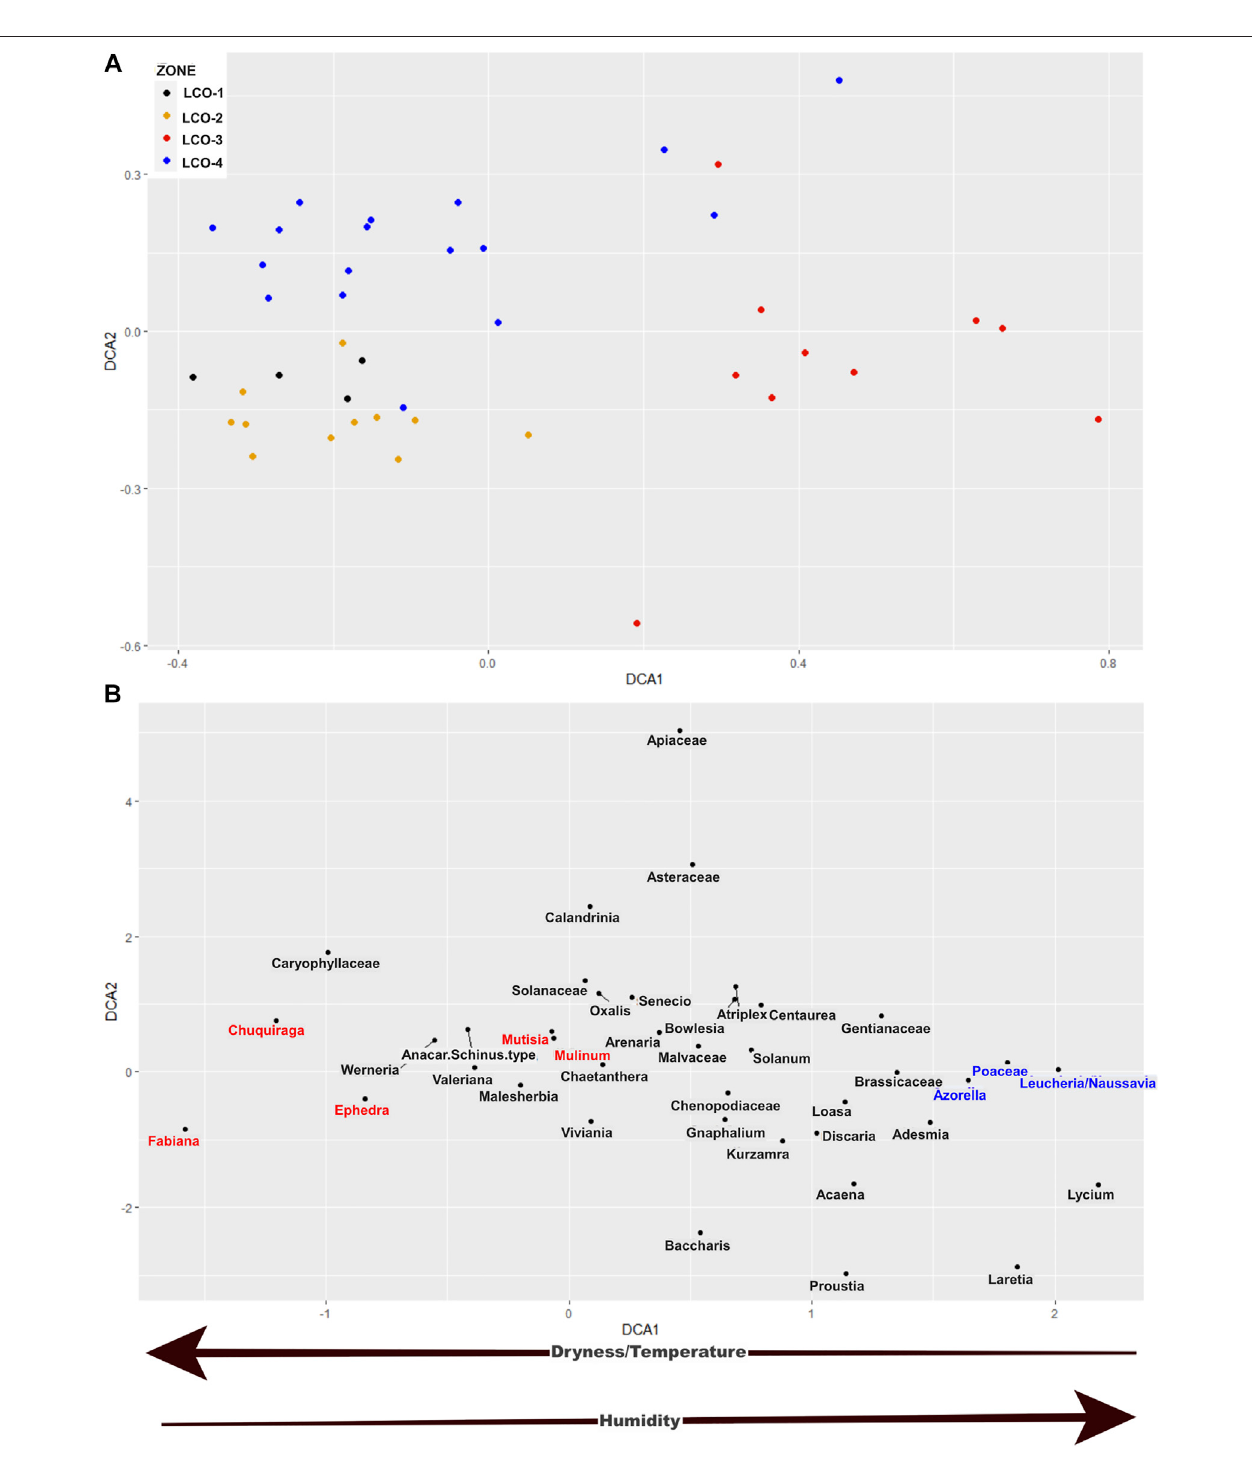
FIGURE 6 | DCA results from the pollen abundance of Laguna Corralito. (A) Ordering of the levels (colored points) grouped in the zones, obtained by the cluster analysis; on the left, are the levels with environmental conditions of lower humidity and on the right, the levels with higher humidity. (B) Ordering of pollen types with a similar arrangement in the multivariate space as the levels. Pollen types related to warmer and less humid conditions are highlighted in red. Pollen types related to cool and humid conditions are highlighted in blue. The arrows below indicate how the humidity and temperature conditions vary along the DCA 1 axis.